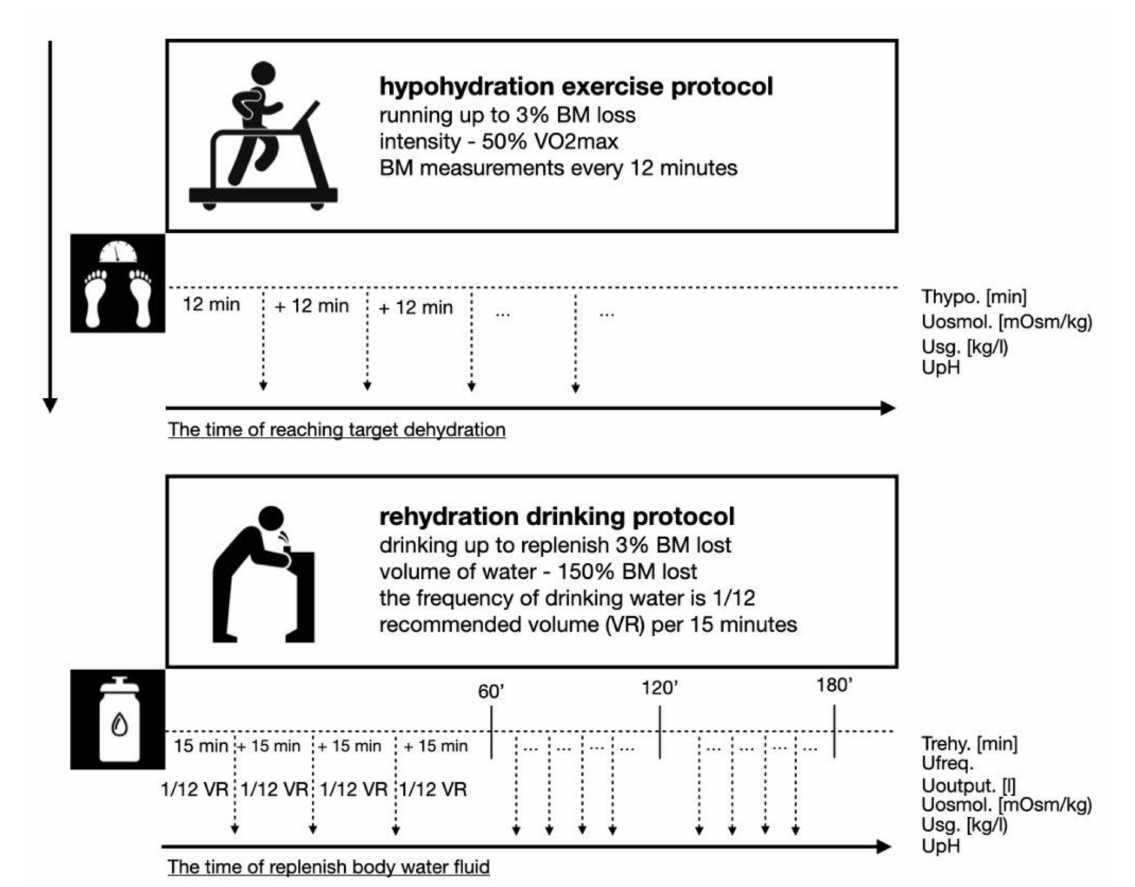
Figure 2. Schematic presentation of the dehydration and rehydration